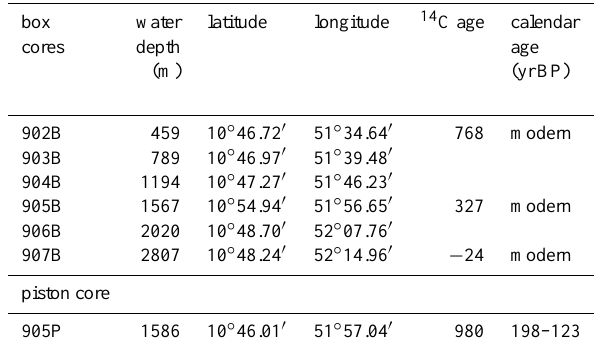
Table 1. Water depth and position of the sediment cores. Radiocar- bon dates (where available) of the upper 1cm performed on surface- dwelling foraminifera. Calendar ages were obtained after reservoir age correction of 800